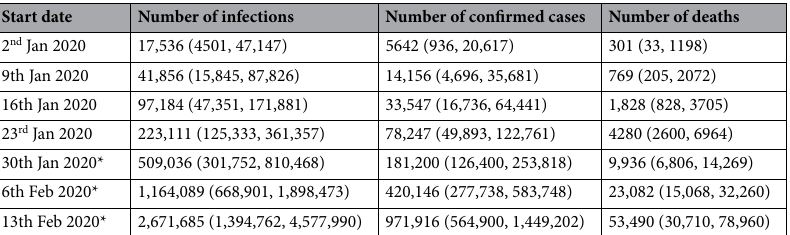
Table 3. Impact of changing the start time of control measures during the outbreak in mainland China on the number of infections, confirmed cases and deaths from 1st December 2019 to 21st April 2020. * China started its Chinese New Year holidays from 25th January 2020, when the number of contacts made between people became much higher than during the other periods of the year. Hence the estimated numbers of cases are likely to be